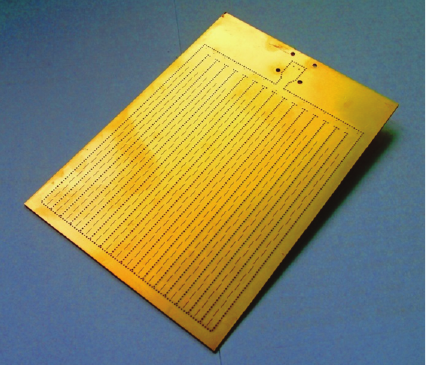
Figure 2: Photograph of the fabricated 16 × 22 SIW slot array antenna.